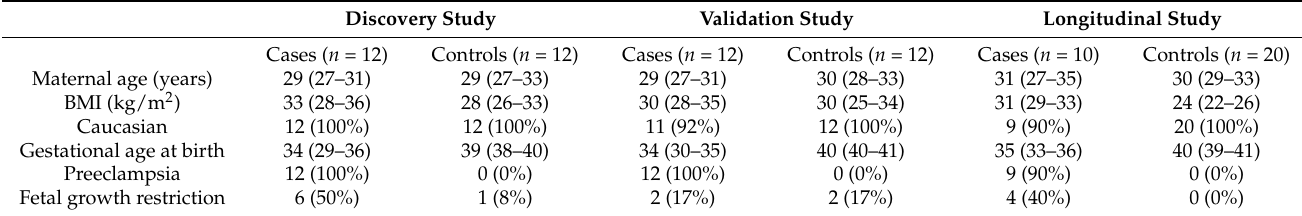
Table 1. Characteristics of our study populations.